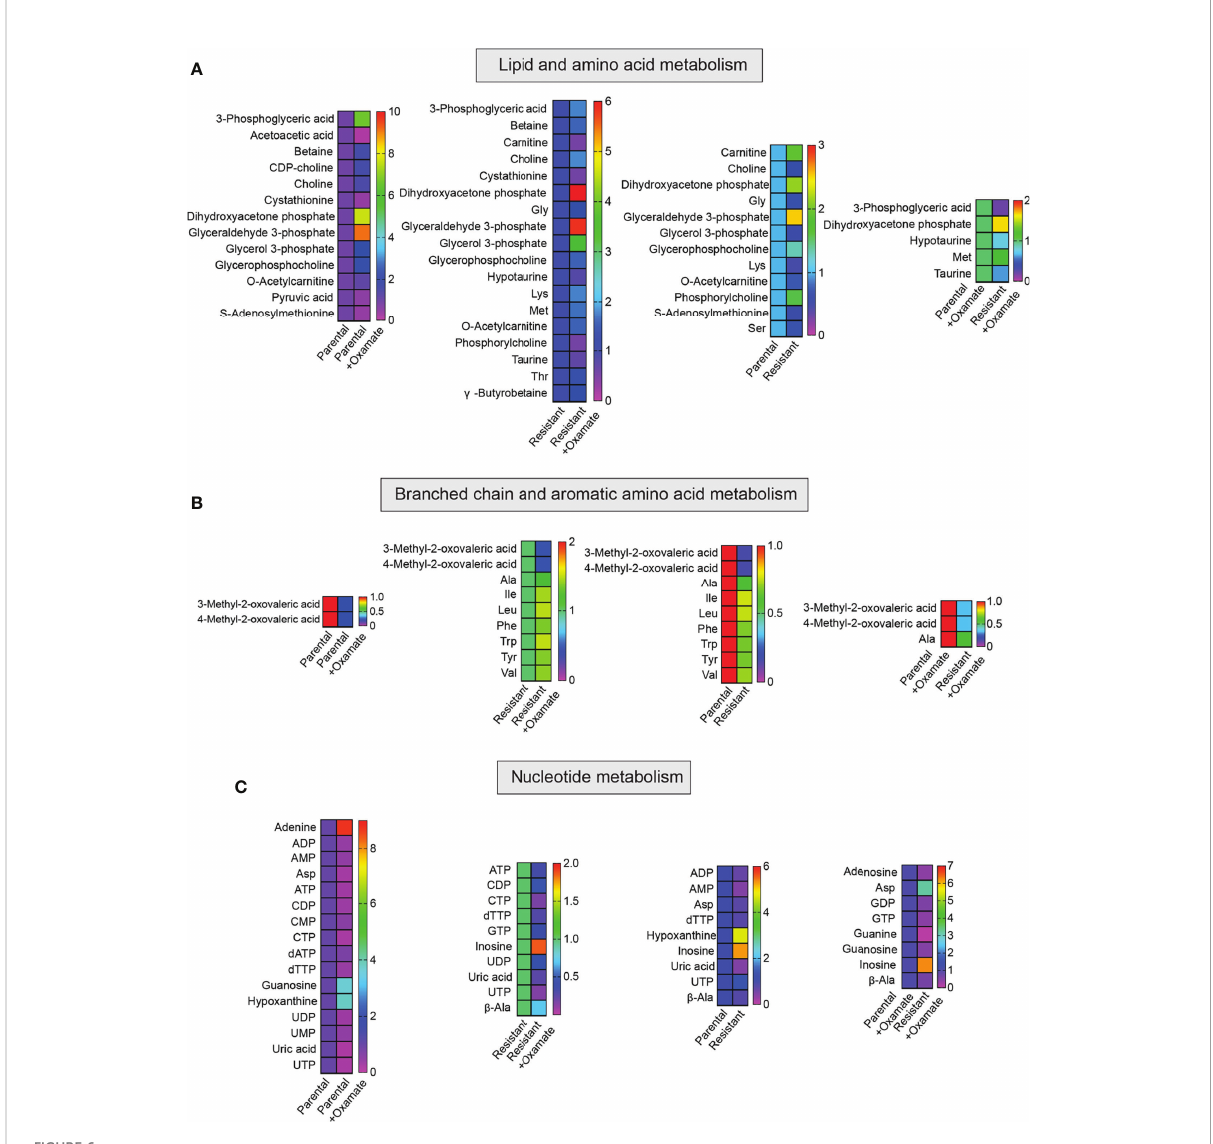
FIGURE 6 Metabolites generated during lipid, amino acid, and nucleotide metabolism in parental and oxamate-resistant cells treated with or without sodium oxamate. (A – C) Changes in the indicated metabolites generated during lipid, amino acid, and nucleotide metabolism under the indicated